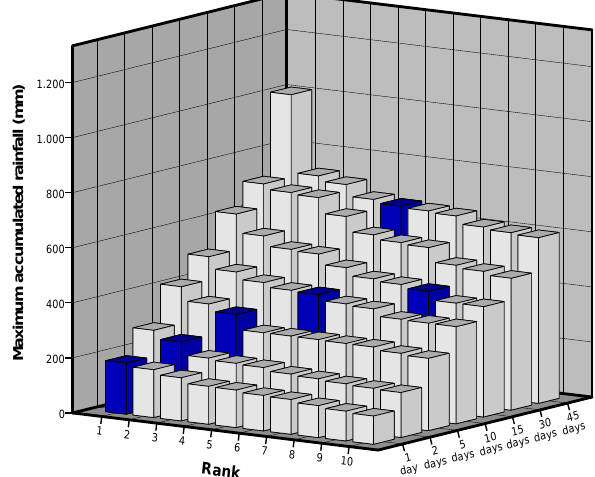
Figure 10. The 10 highest values (rank) of maximum accumulated precipitation from 1, 2, 5, 10, 15, 30, and 45 days in Guarda for the period 1906–1994. Blue bars correspond to the December 1909